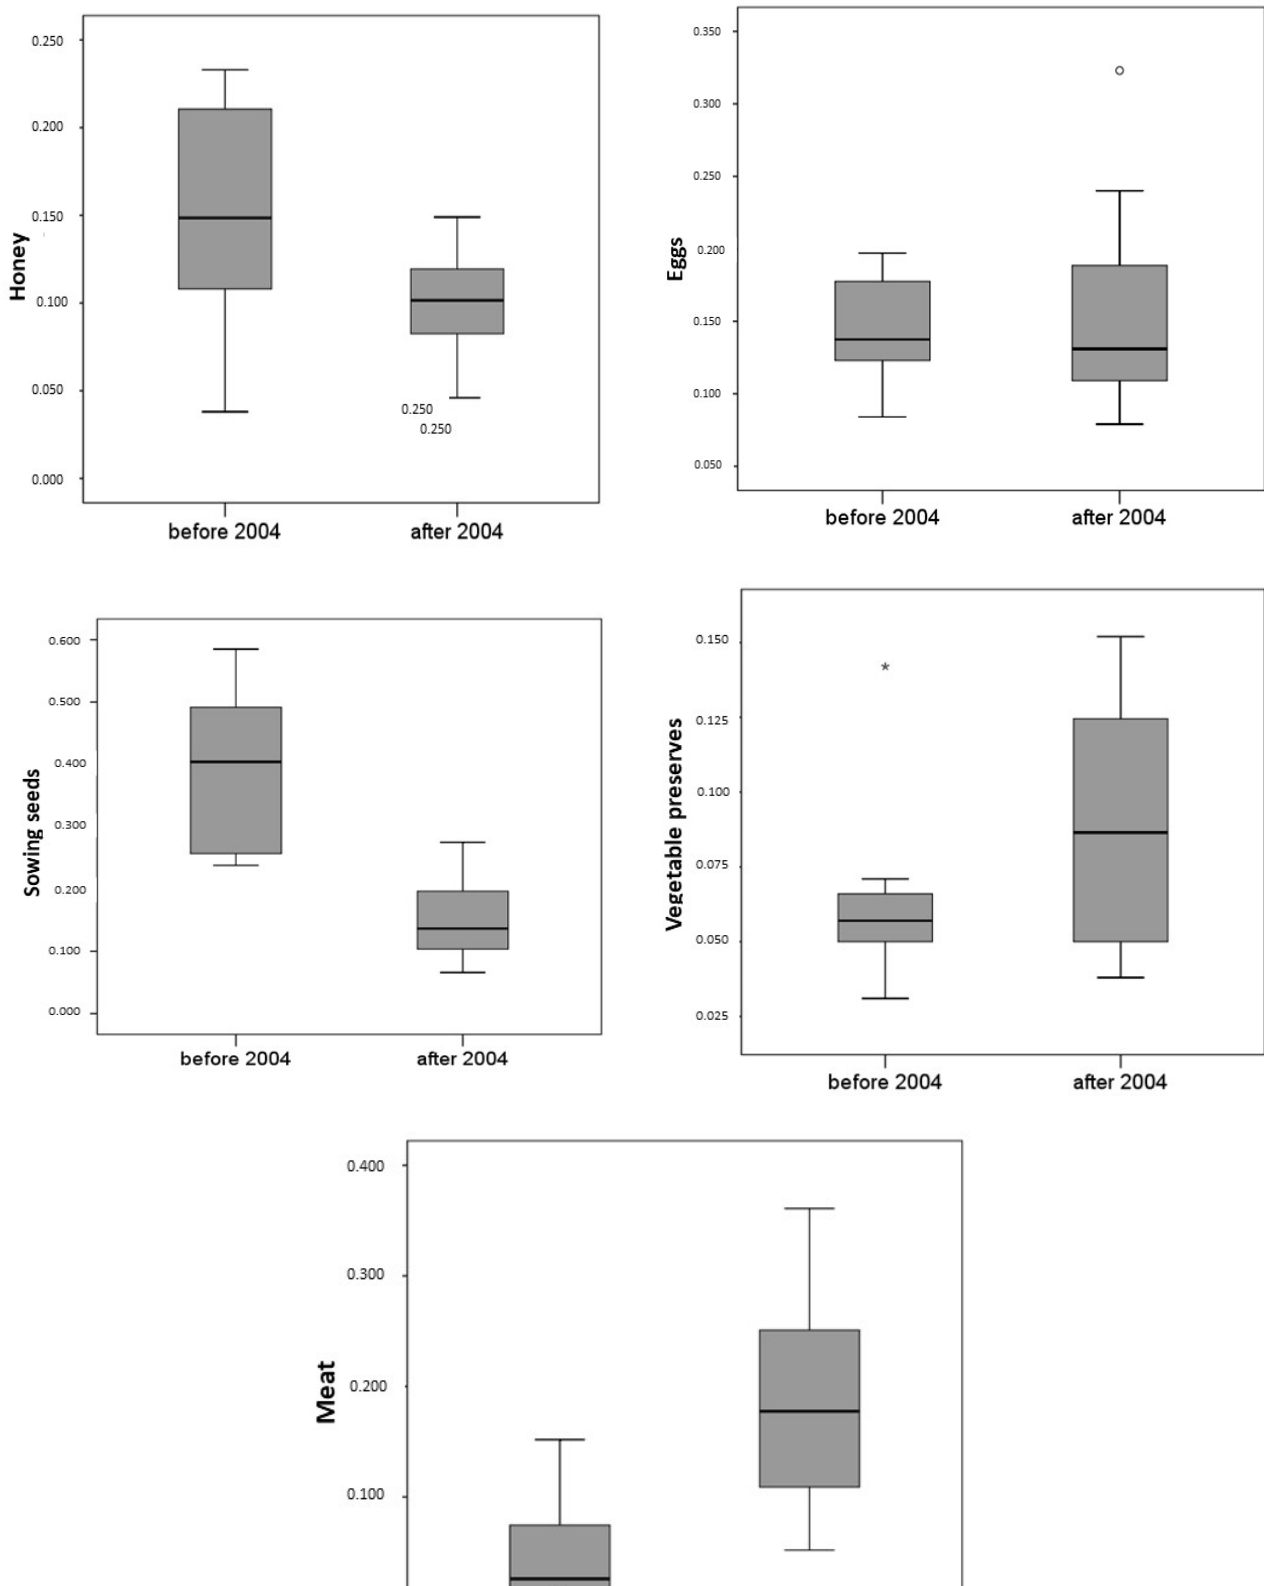
Figure 2. Boxplots of dispute rates for each foods